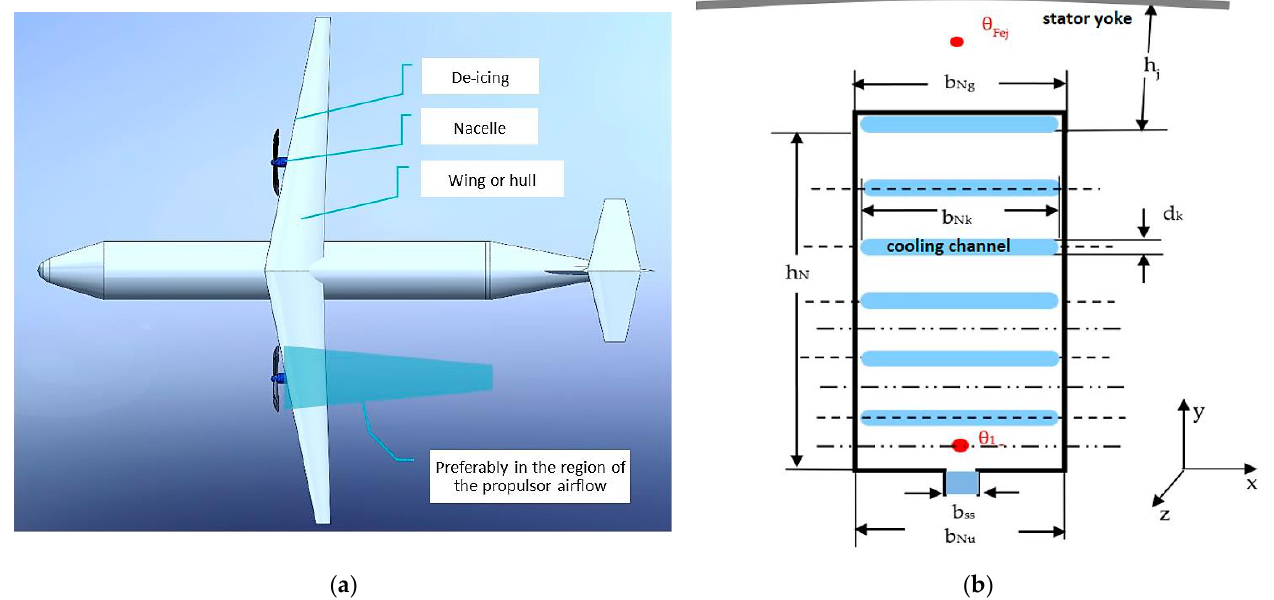
Figure 7. ( a ) Small-range aircraft topology considered in [15] to study the optimization of the winding slot cooling on aircraft 2 MW PMSM for decreasing the weight of the electric drive system. ( b ) The layout of designed cooling channels in the electrical machine slot.